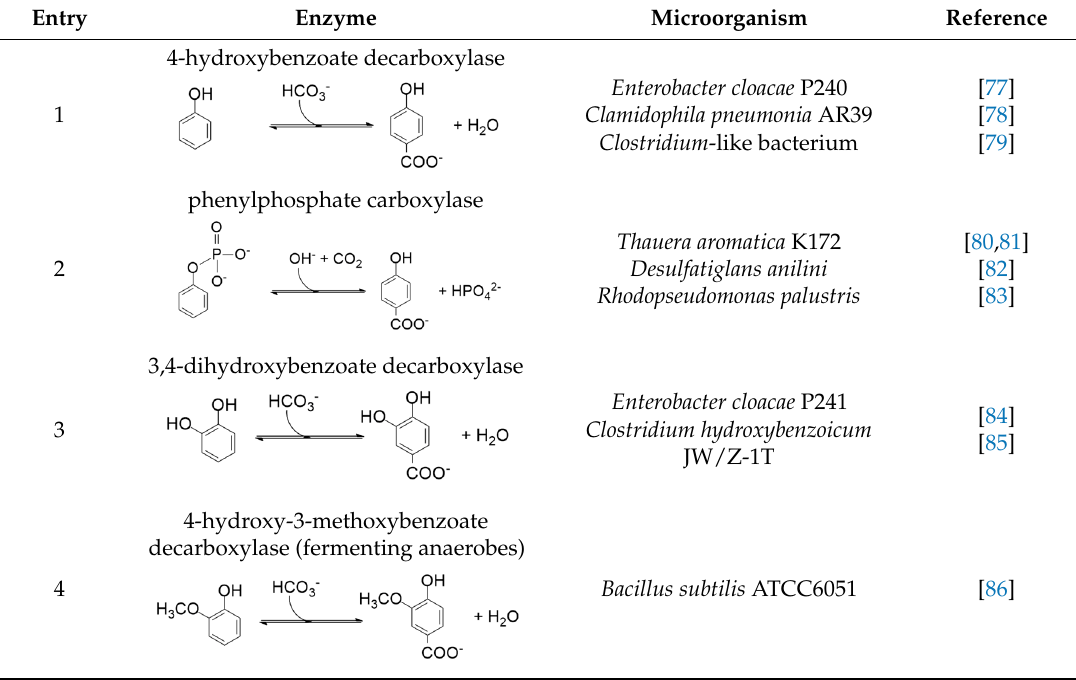
Table 9. List of decarboxylase enzymes catalyzing the regioselective para -carboxylation reaction of hydroxyl aromatic substrates recently characterized.